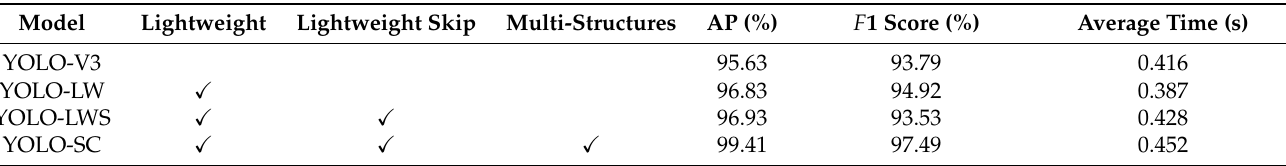
Table 8. Results of ablation studies with different variations. The “ (cid:88) ” indicates that the corresponding sub-module has been added to the